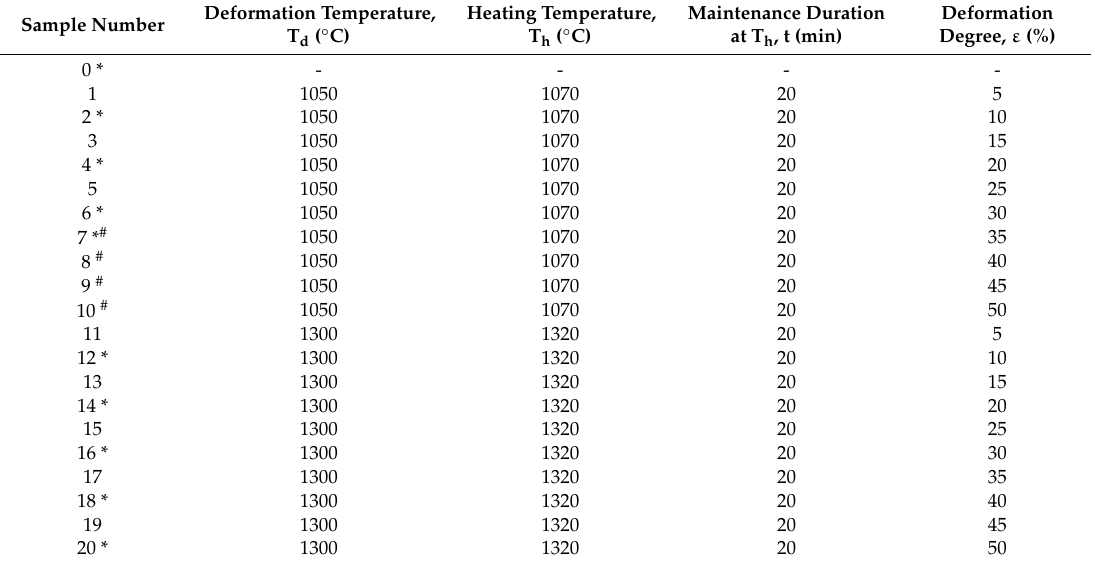
Table 1. Parameters of the experimental program.